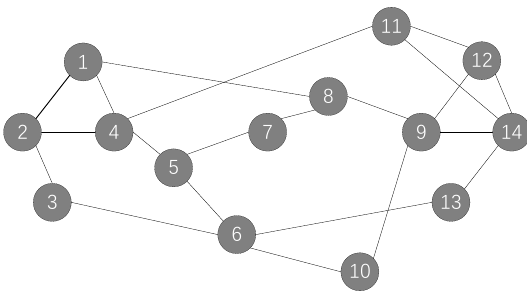
Figure 3. NSFNET network topology.